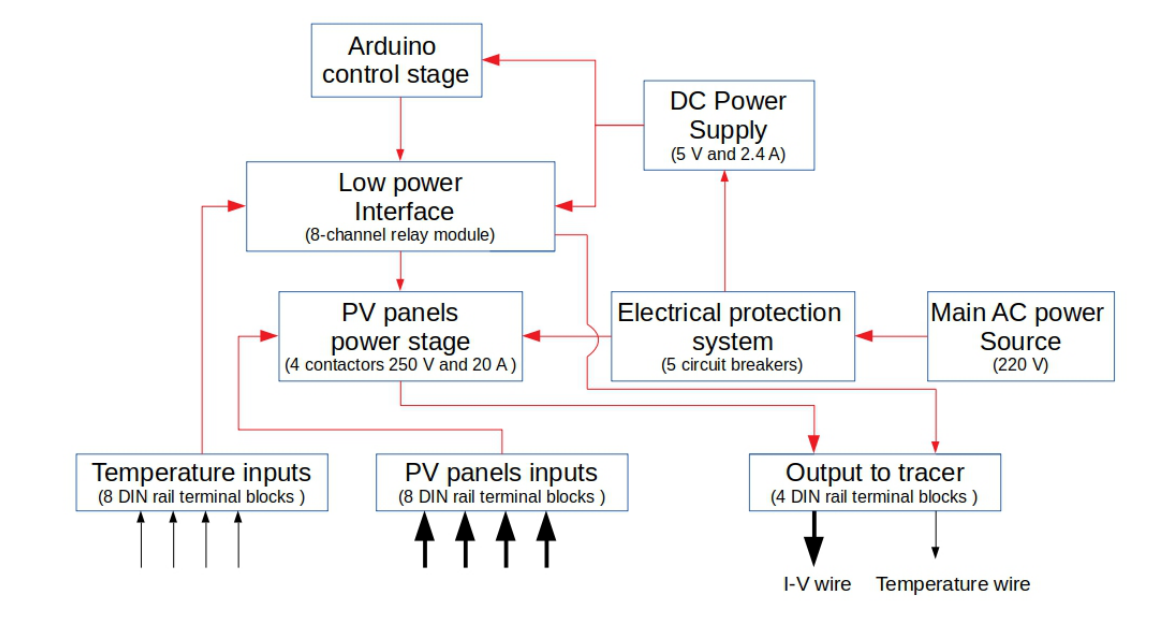
Figure 3. Block diagram for the UHU-MUX multiplexer.